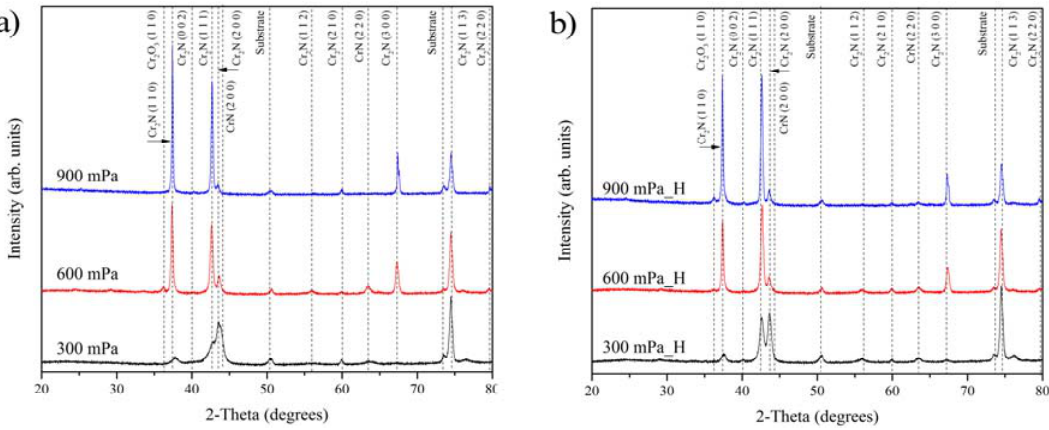
Figure 3. XRD of CrxN coatings deposited at different pressures ( a ) before; and ( b ) after Figure 3. XRD of Cr x N coatings deposited at different pressures ( a ) before; and ( b ) after hydrogenation.